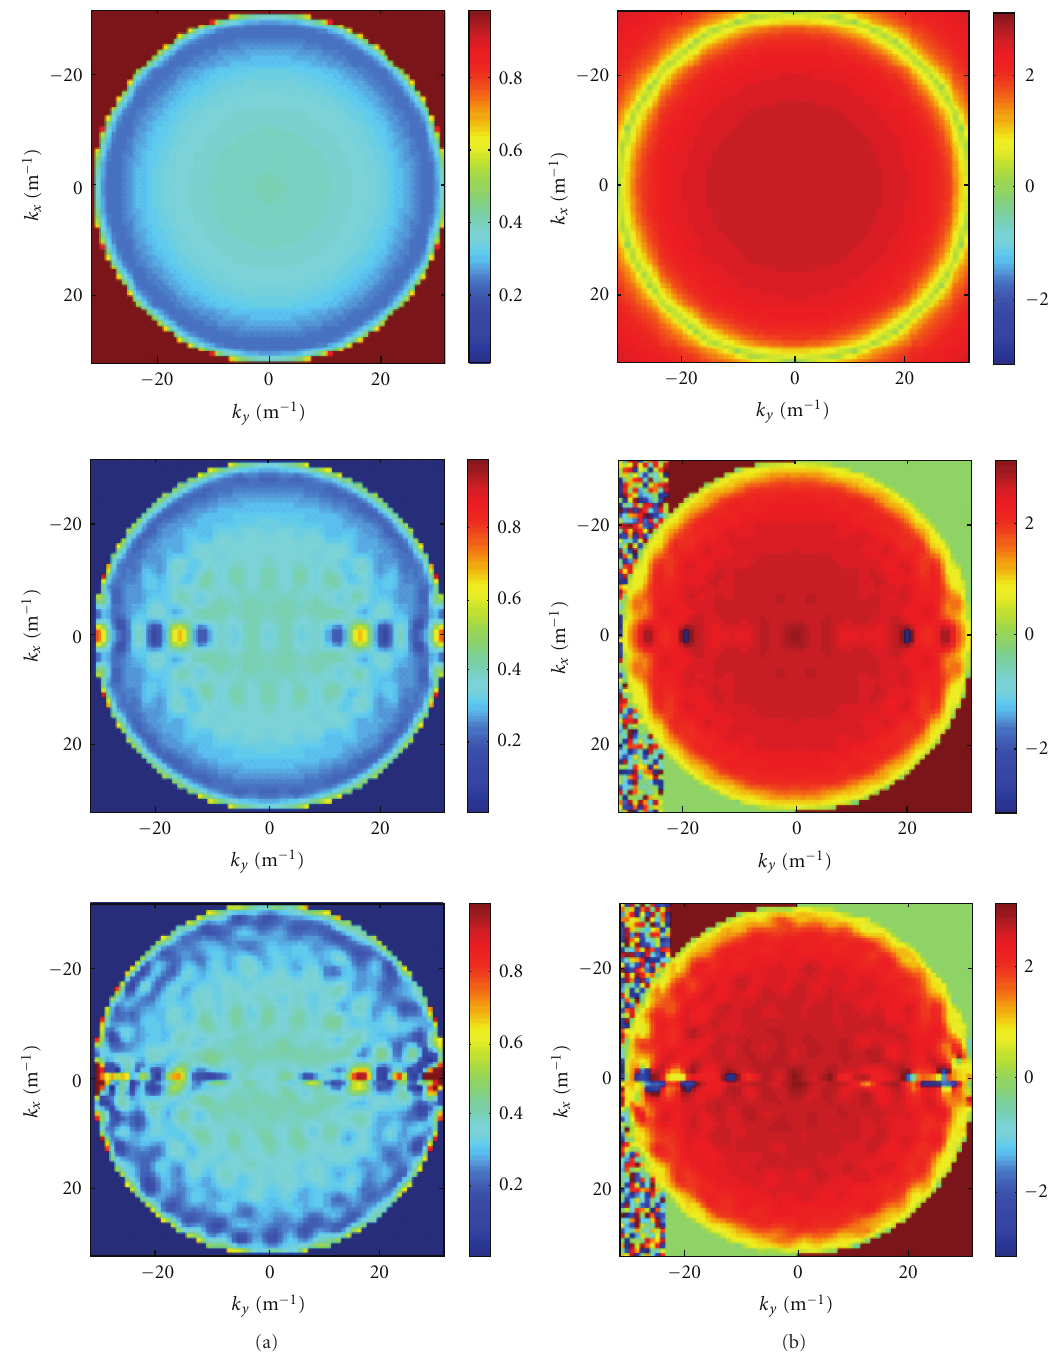
Figure 7: Soil 2. Amplitude (a) and phase (b) of Γ TM . Top line: actual values; middle line: noiseless estimation; bottom line: noisy